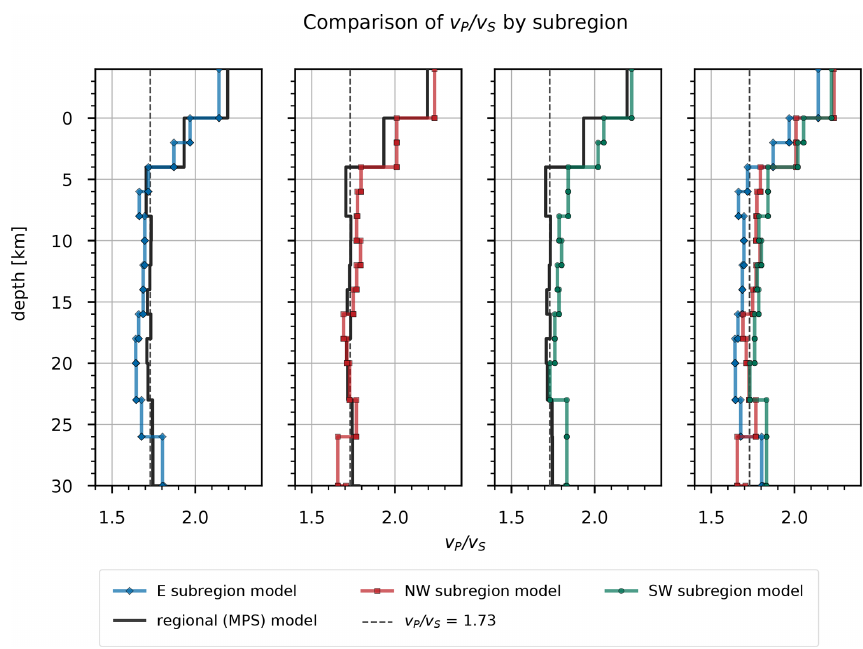
Figure 15. P-velocity to S-velocity ratio ( v P /v S ) values calculated for a particular subregion. The thick black line shows v P /v S values of the regional (MPS) model. Corresponding values are given in Tables S4, S5, and S6.